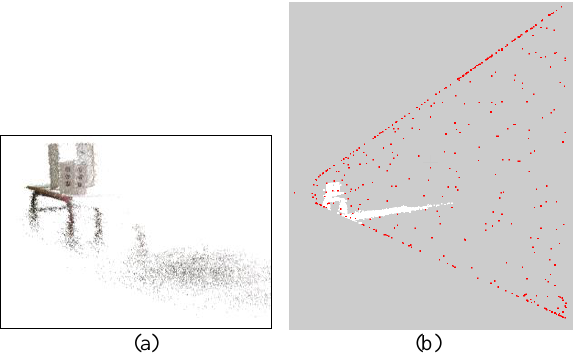
Figure 8. Point cloud acquired in sunny conditions: (a) scene without “flying pixels”; (b) scene (white) and “flying pixels” (red) in a profile